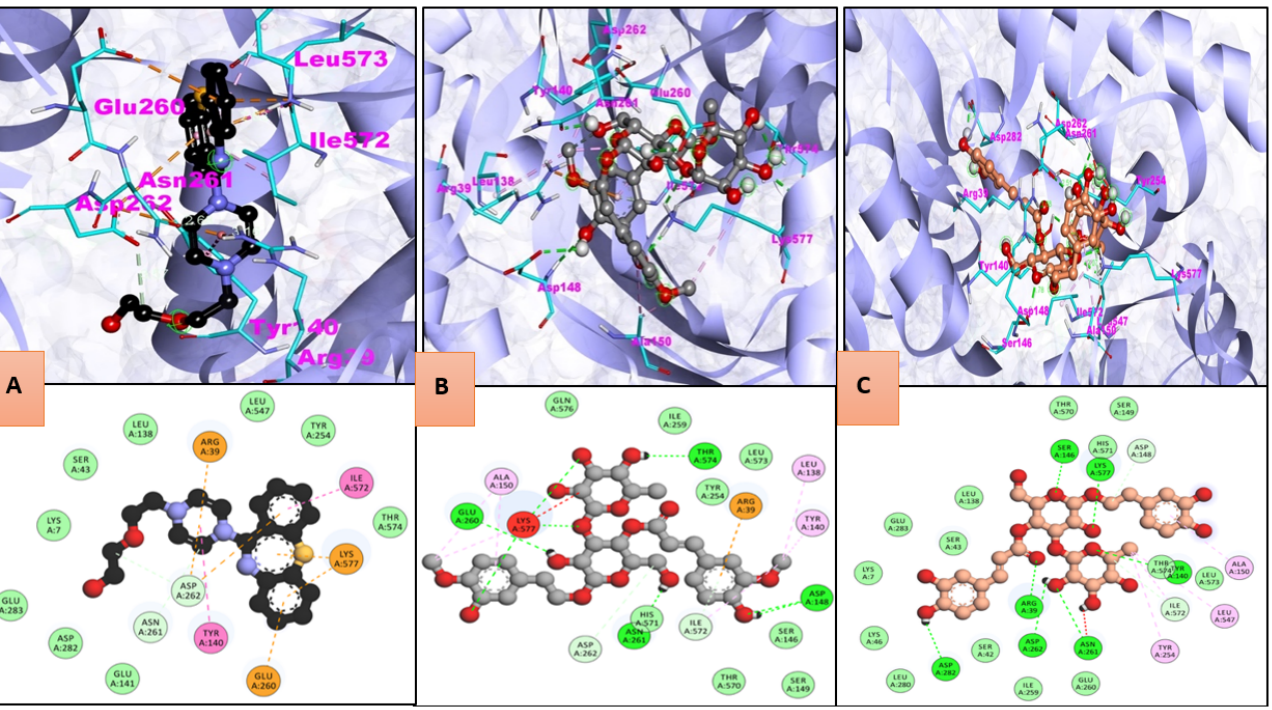
Figure 3. Three-dimensional and 2D interaction of active site residues of STXBP1 with ( A ) control, ( B ) CID:5319292, and ( C ) CID:5281800. Table 2. Molecular docking data of top nine selected natural compounds of Bacopa interaction with STXBP1.